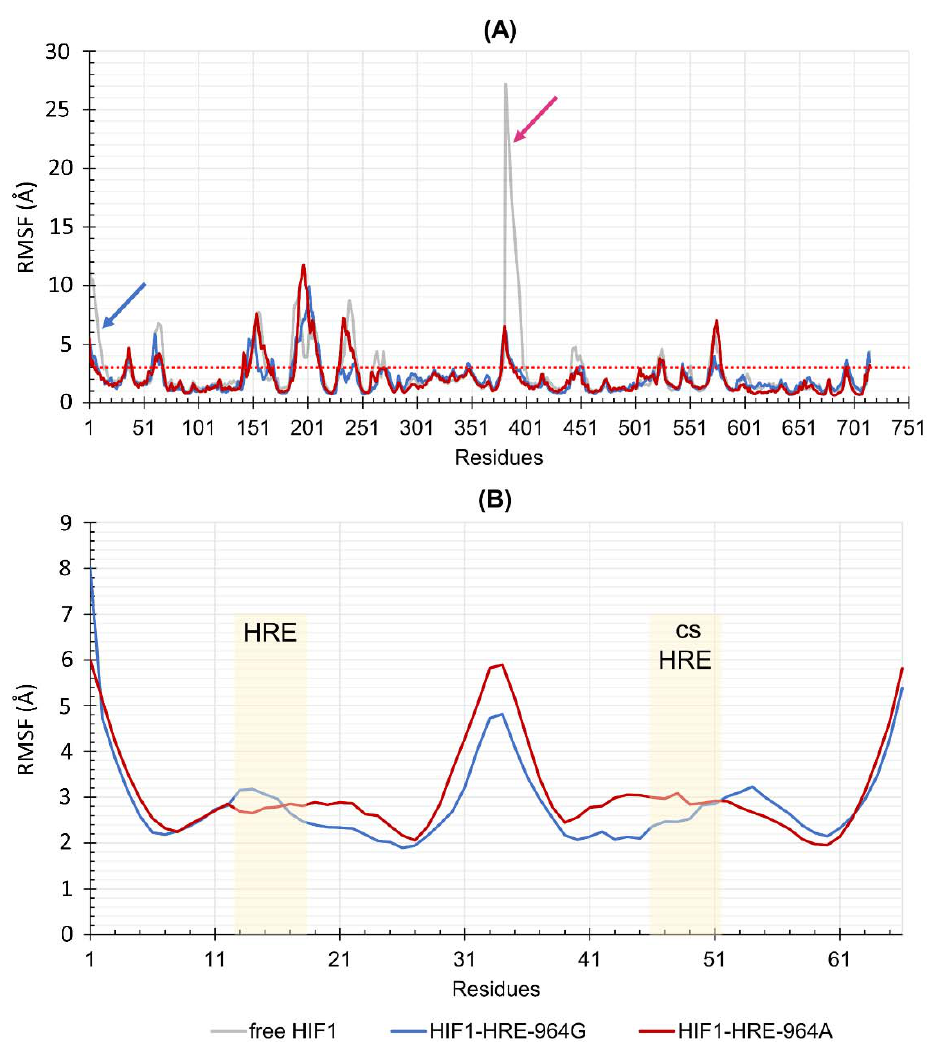
Figure 6. ( A ) RMSF values for the HIF1-HRE complexes according to the HLA-G − 964G > A polymorphism. Residues 1 to 381 correspond to the ARNT subunit and residues 382 to 715 correspond to the HIF1a subunit. The dotted red line marks the amino acids with RMSF > 3.0 Å. The blue and pink arrows indicate the α -helices 1 of the ARNT (residues 1 to 18) and of the HIF1a (residues 382 to 400), respectively. ( B ) Comparisons of the DNA of the complex according to the HLA-G − 964G > A polymorphism. Residues 15 to 19 correspond to the − 966 to 962 hypoxia-responsive element (HRE) sequence and residues 48 to 52 correspond to the − 966r to − 962r complementary nucleotide sequence to the HRE. Both are highlighted in the beige boxes (the forward: HRE and the nucleotide sequence complementary to the HRE: csHRE). Each strand of DNA contains 33 bp. Note: Author's own image.